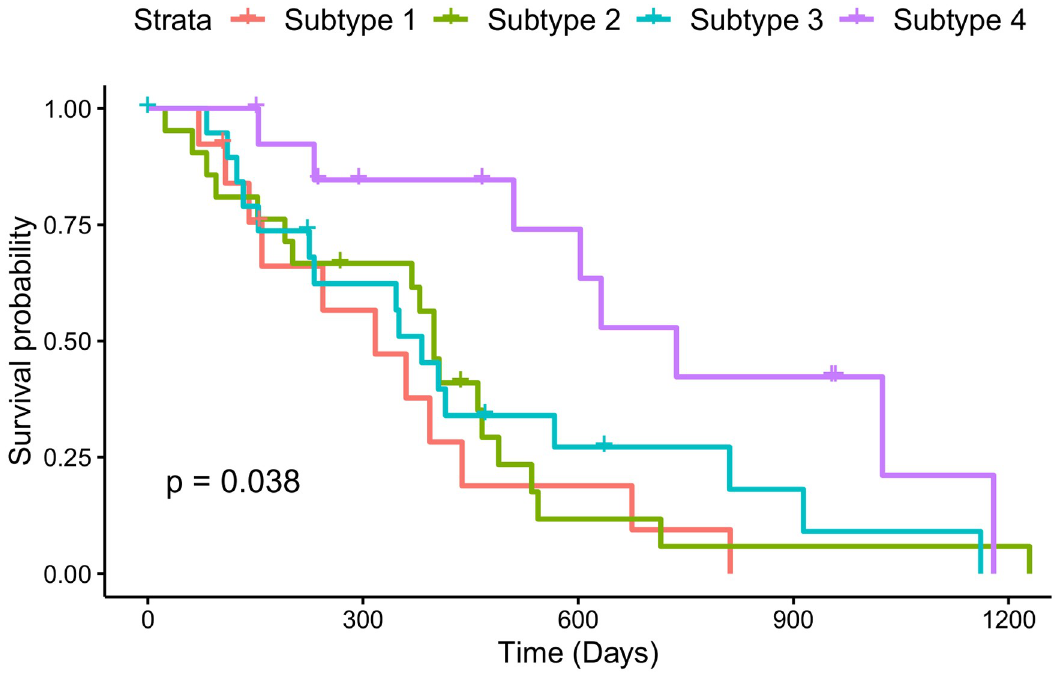
Fig 4. Survival analysis for identified subtypes of